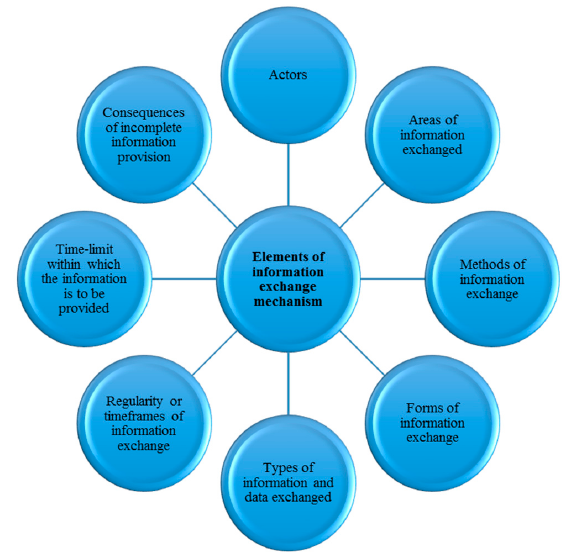
Figure 2. Elements of information exchange mechanism developed for improved access to the network for cross-border exchanges in electricity [30].